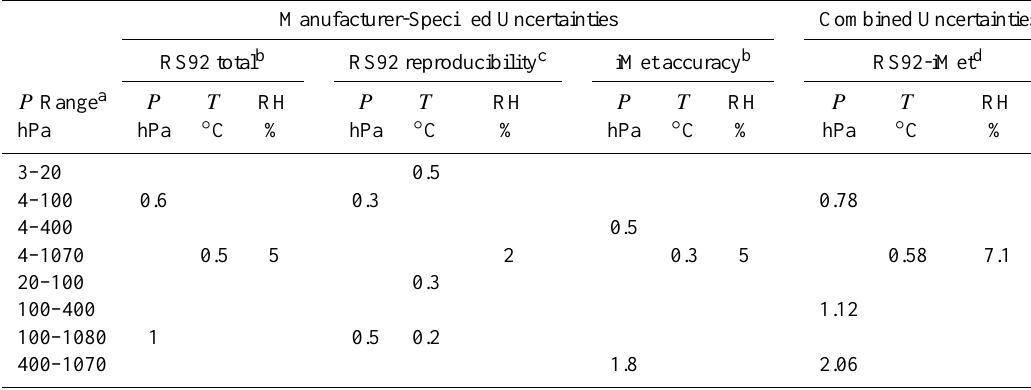
Table 2. Manufacturer-specified and combined uncertainties for radiosonde measurements. Manufacturer-Specified